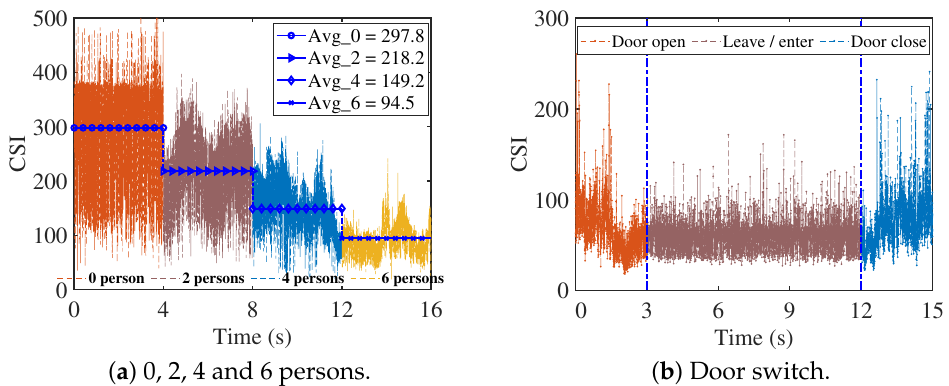
Figure 1. CSI measurements of one